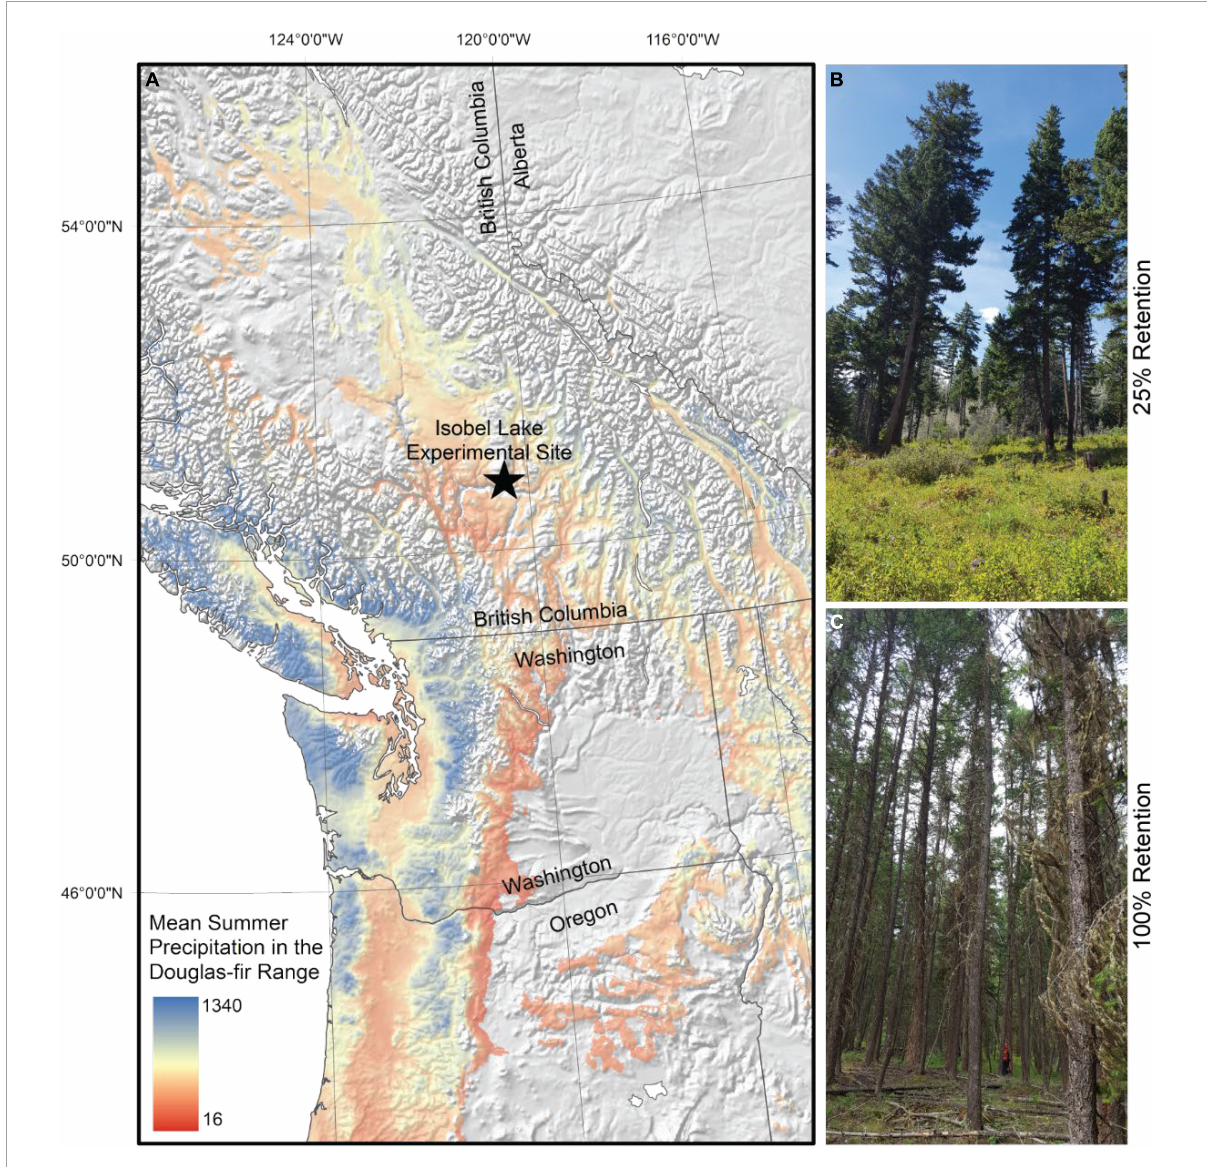
FIGURE1 (A) Map of the distribution of Douglas-fir in the Pacific Northwest, shaded by mean annual temperature. The location of the experimental site is indicated by a star. The map was created by the authors using vector and raster data from www.naturalearthdata.com (Public Domain) and (Hamann et al., 2005). (B) Photo taken in treatment unit 9, showing stand conditions 17 years after harvest in the 25% retention treatment. (C) Photo taken in treatment unit 11, showing stand conditions of the no-treatment control 17 years after establishment of the